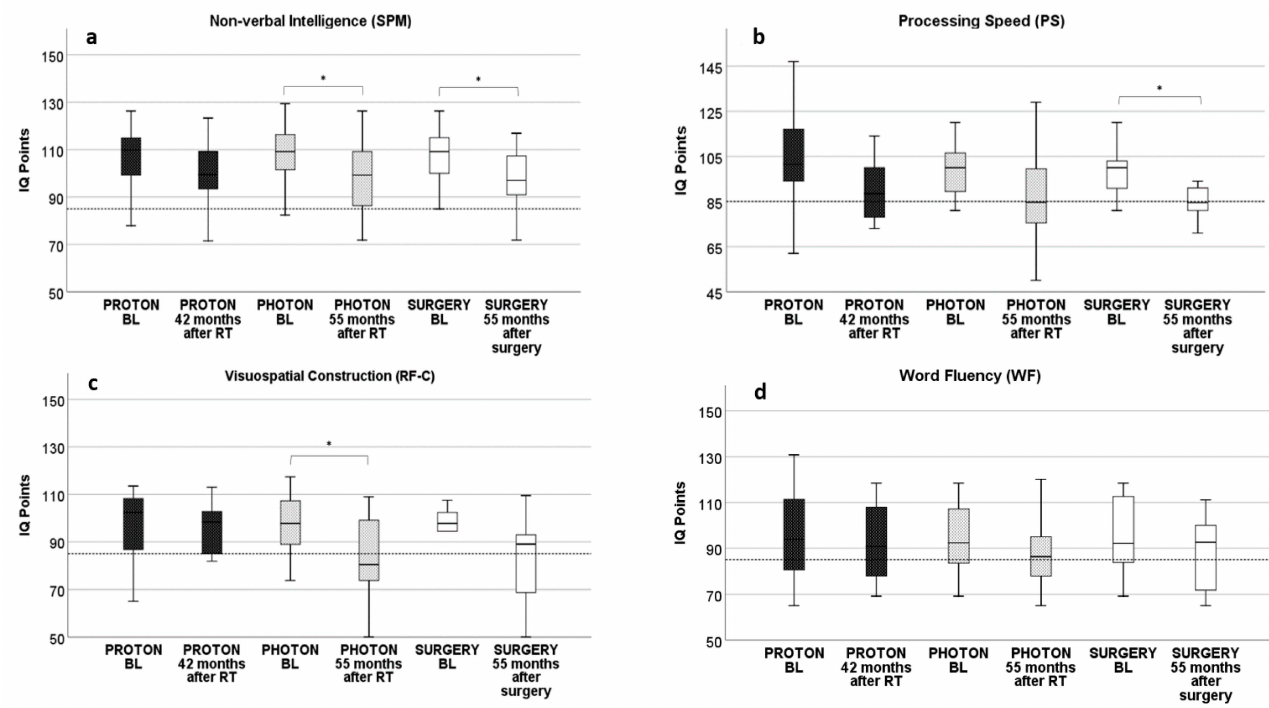
Figure 2. Neurocognitive test results of four main domains showing no significant difference in intermodal group com- parison. Significant changes are indicated by *. Dotted line at 85 IQ points indicates a threshold below average values. Abbreviations: IQ = intelligence quotient, RT = radiation therapy, SPM = Standard Progressive Matrices, PS = processing speed, RF-C = Rey Figure for visuospatial construction, WF = word fluency. ( a ) Results of non-verbal intelligence showing significant decrease in longitudinal follow-up in the photon and surgery cohort; no differences in intermodal group compar- ison, all values above average ( b ) Results in processing speed showing significant decrease in longitudinal development in the surgery cohort with below average results in the surgery and photon cohort after 55 months of follow-up ( c ) Results of visuospatial construction with significant decrease in longitudinal follow-up in the photon cohort, mean results above average at any follow-up; no differences in intermodal group comparison ( d ) Results of word fluency with no significant alteration in longitudinal follow-up and no significant differences in intermodal group